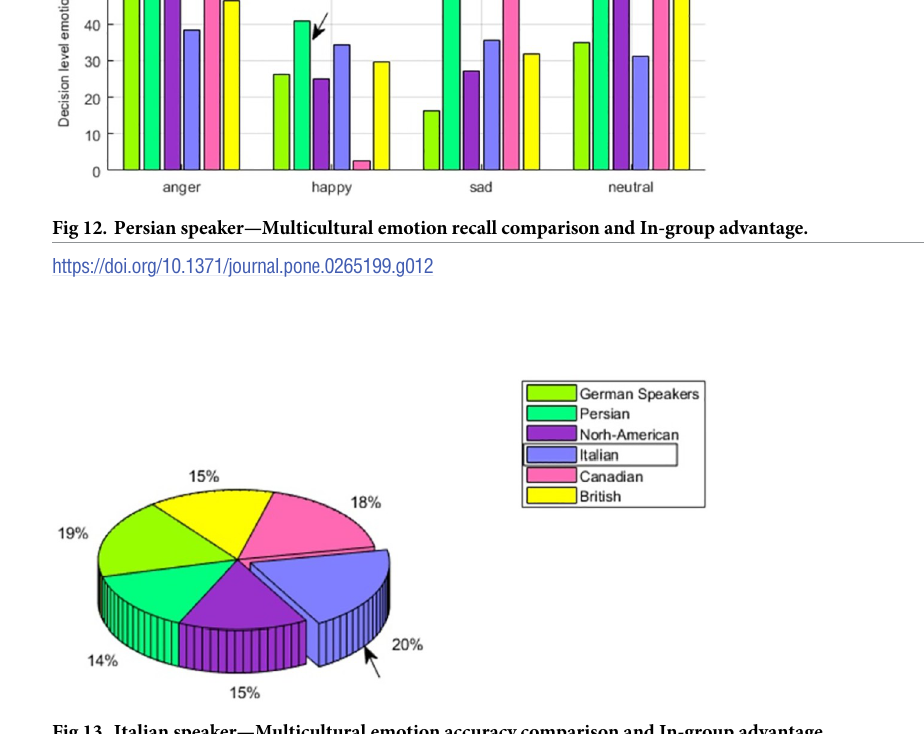
Fig 13. Italian speaker—Multicultural emotion accuracy comparison and In-group advantage.